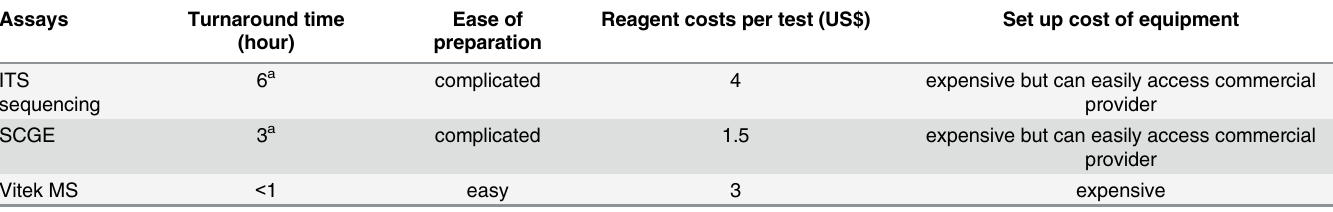
Table 4. Comparison of SCGE, Vitek MS and ITS sequencing for identification of yeast